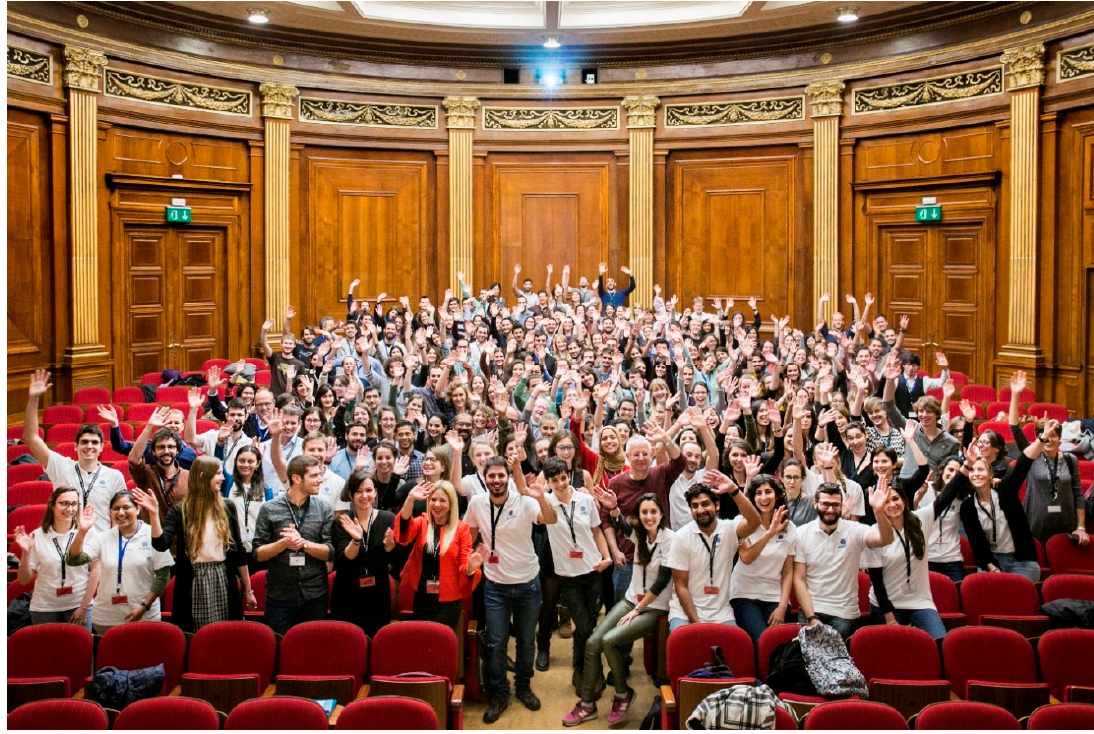
Figure 1. Attendees at ENABLE